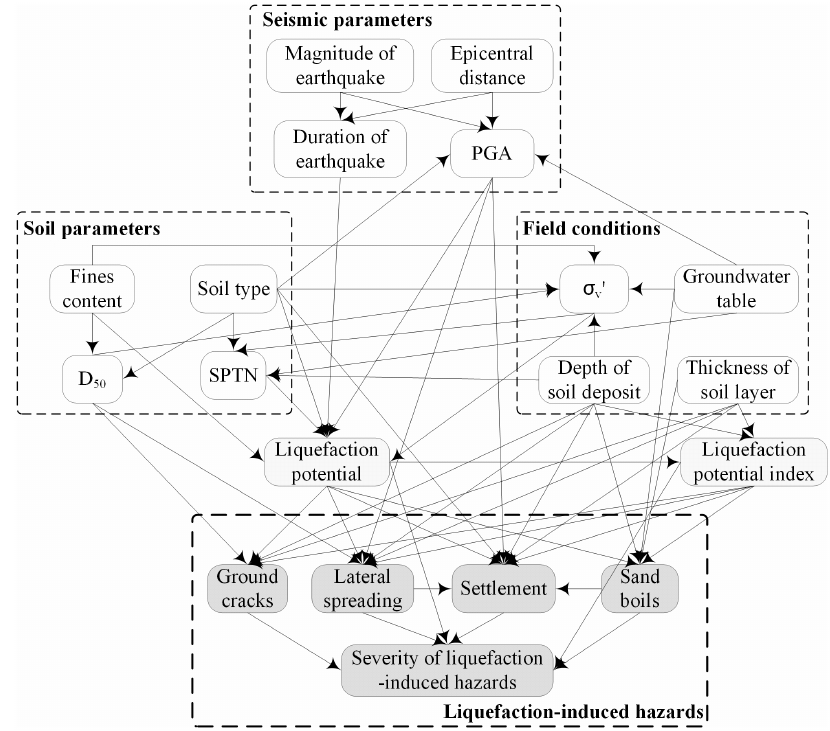
Figure 4. A BN model of seismic liquefaction-induced hazards.